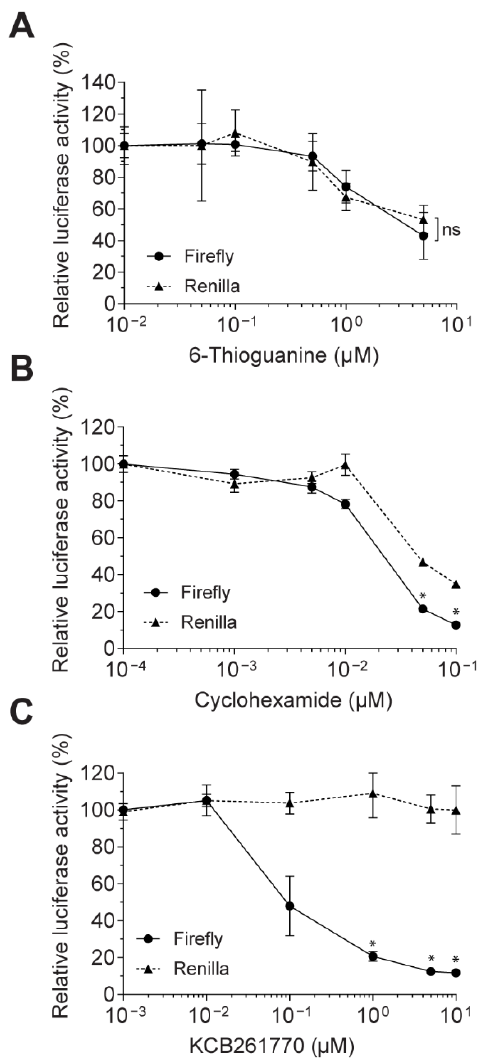
Figure 4. Frameshifting inhibition by compound KCB261770 without decreasing cap-dependent translation. ( A – C ) Relative firefly and Renilla luciferase activities were measured in the cells har- boring MERS-CoV − 1 PRF plasmids treated with increasing concentrations of 6-thioguanine ( A ), cycloheximide (CHX; B ), and compound KCB261770 ( C ). Circles with solid lines indicate firefly luciferase activities and triangles with dashed lines Renilla luciferase activities. * p < 0.05, ns; not significant (two-way ANOVA with Sidak’s multiple comparisons test).